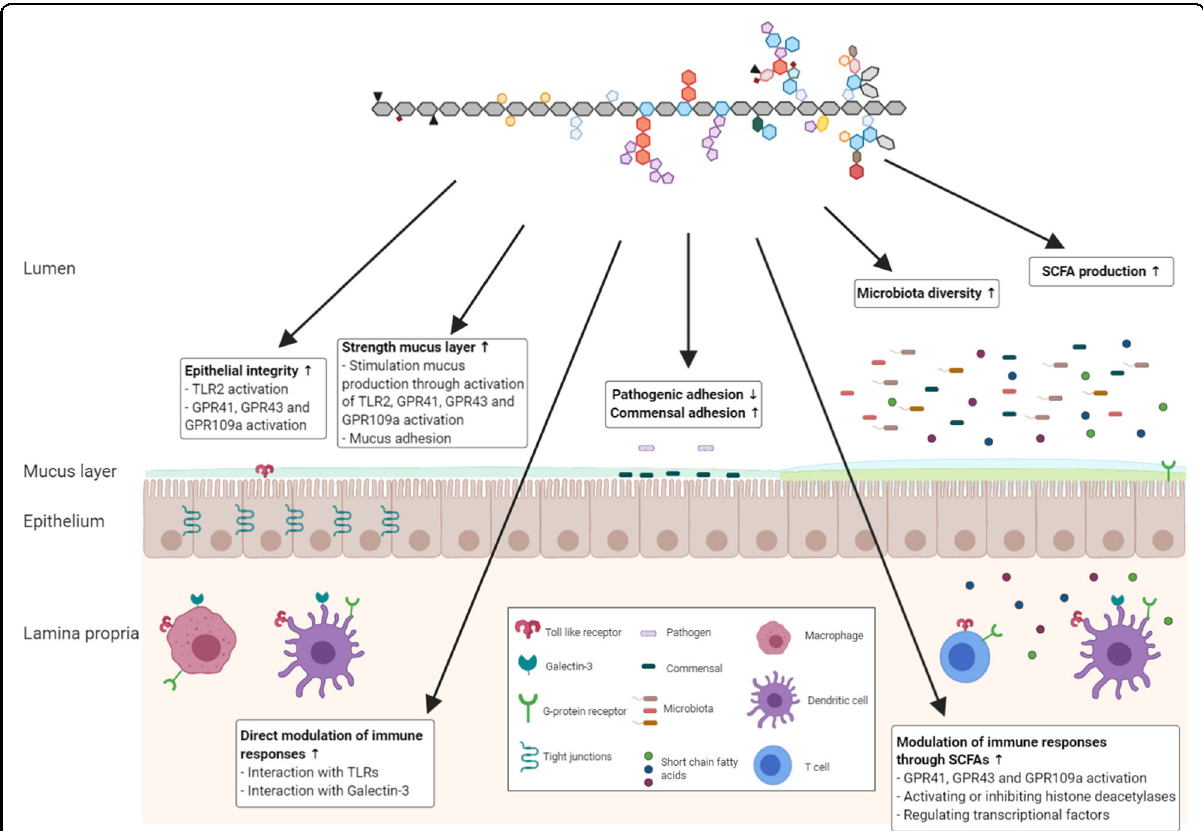
Fig. 4 In fl uence of pectins on the gastrointestinal immune barrier. Pectins can in fl uence the gastrointestinal immune barrier in a microbiota- dependent (indirect effects) and microbiota-independent (direct effects) manner. Direct effects include strengthening of the mucus layer, stimulation of epithelial integrity or modulation of immune responses. Pectins can exert direct effects through interaction with galectins or TLRs. Indirect effects include stimulation of microbial diversity, production of SCFAs, favoring adhesion of commensals to epithelial cells or anti-adhesive effects of pathogens to epithelial cells. SCFAs may stimulate epithelial integrity and mucus secretion by binding to GPR41, GPR43, or GPR109a. Immune responses are also in fl uenced by SCFAs, which may interact with GPR41, GPR43, or GPR109a, activate or inhibit histone deacetylases or regulate transcription